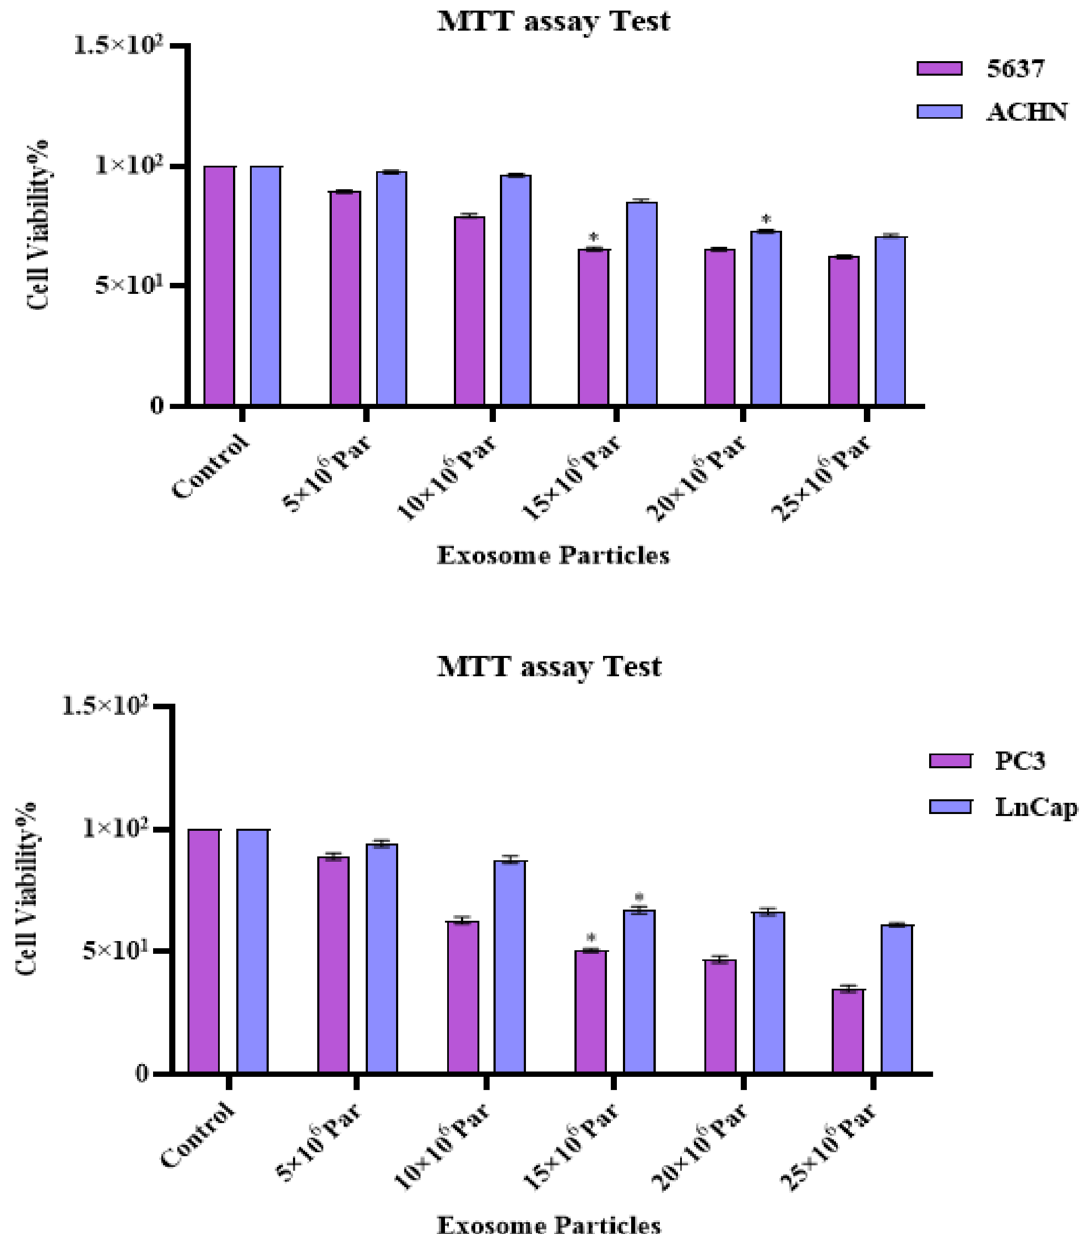
Figure 4. Effects of exosomes in different concentrations (0–25 × 10 6 Par) on cell proliferation. The anti-growth effect of exosomes was measured by M.T.T. assay following 24, 48, and 72 h in 5637, ACHN, LNCaP, and PC3 cell lines. IC50 pharmaceutical doses of 15 × 10 6 Particle in PC3, LNCap, and 5637 cell line and 15 × 10 6 Particle in ACHN cell line were determined. Data showed that exosomes’ anti-proliferative impact reduces cell viability with a dose- and time-dependent